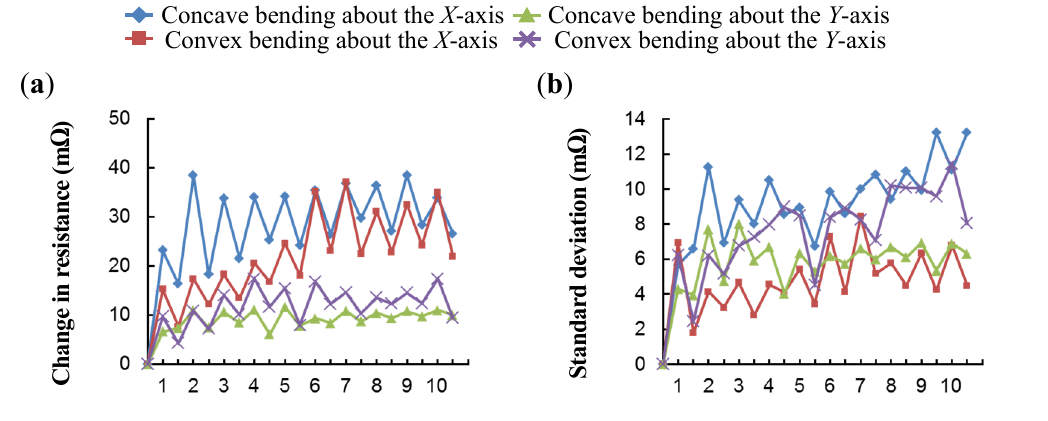
Figure 11. Change in resistance during the bending test for a curvature radius of 70 mm: ( a , b ) continuous measurements and ( c , d ) intermittent measurements.